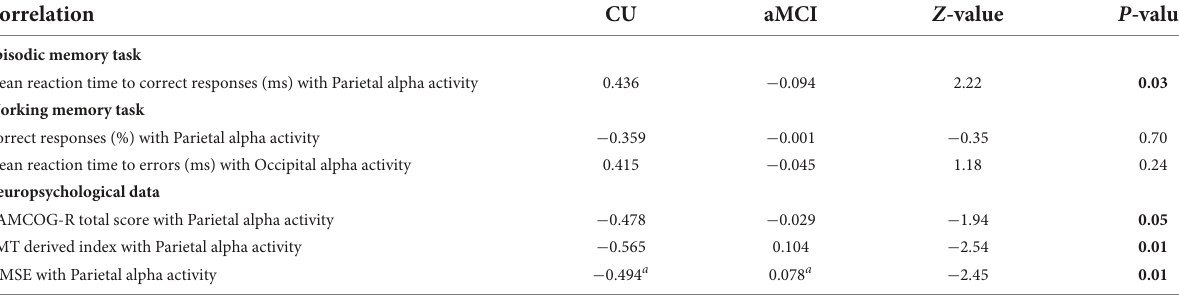
TABLE 8 Correlations (Pearson’s r ) between eLORETA source solutions (normalized source current density) of parietal and occipital alpha rsEEG rhythms and episodic memory task, working memory task, and neuropsychological test scores for CU and aMCI groups, alongside p -values of the statistical comparison between the correlation coefficients of each group for each